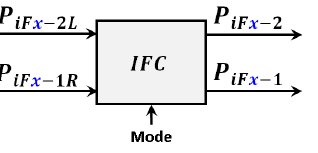
Figure 6. Block diagram of the programmed model of the IFC.